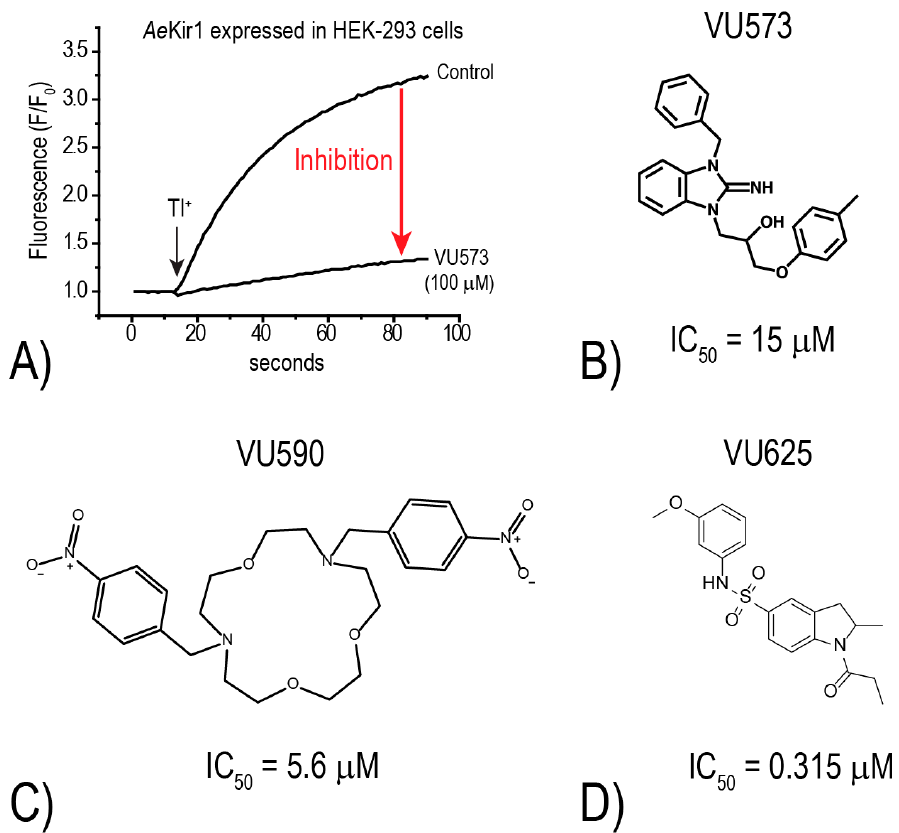
Figure 4. Discovery of small molecule inhibitors of Ae Kir1. ( A ) Tl + -flux assay showing the rapid increase of fluorescence (F/F 0 ) in HEK-293 cells expressing Ae Kir1 upon addition of Tl + (black arrow) to the extracellular bath (Control). If the cells are incubated with VU573 (100 μ M) prior to addition of Tl + , the increase of fluorescence is nominal, suggesting inhibition of Ae Kir1. Modified from [18]. ( B – D ) Structures of small molecule inhibitors of Ae Kir1 discovered by the Denton laboratory. The respective potencies of the compounds (IC 50 ) in the Tl + flux assays are indicated. Data are from [18–20].